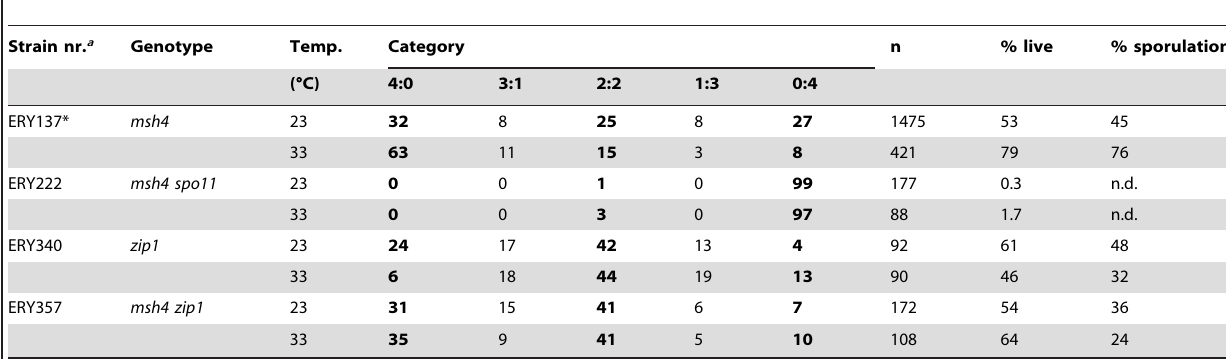
a Data for ERY137 and ERY340 from Table 4. * Significantly different distributions (P , 0.017, G-test) of viable spore classes and proportion of four-viable spores at 33 u C compared to 23 u C. n.d.- not determined. doi:10.1371/journal.pone.0007284.t005 PLoS ONE |